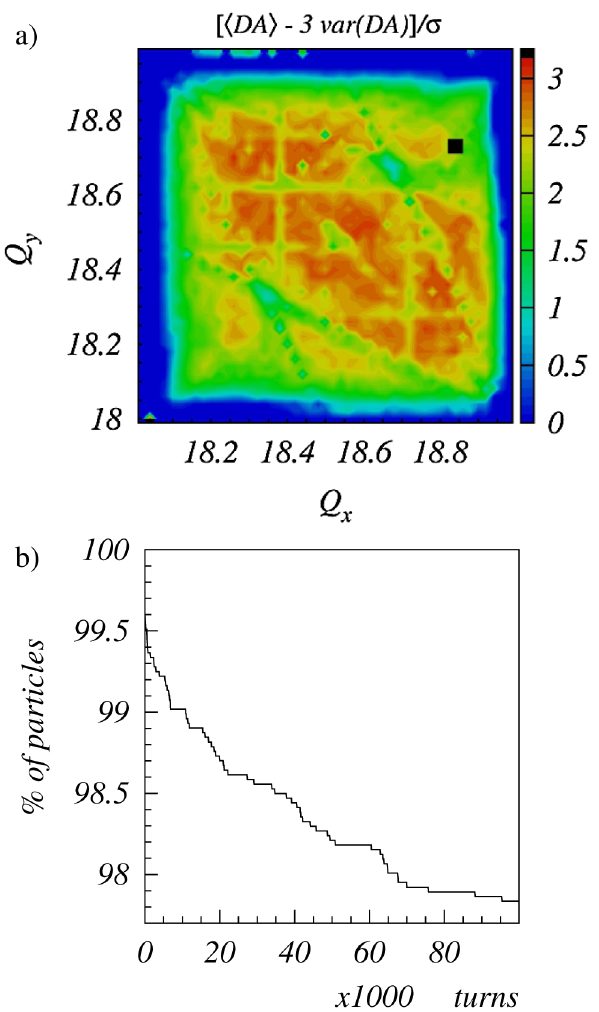
FIG. 11. (Color) SIS100 dynamic-aperture scans with reference random errors (top). Black marker: proposed working point WP1; beam 2 for the standard error case